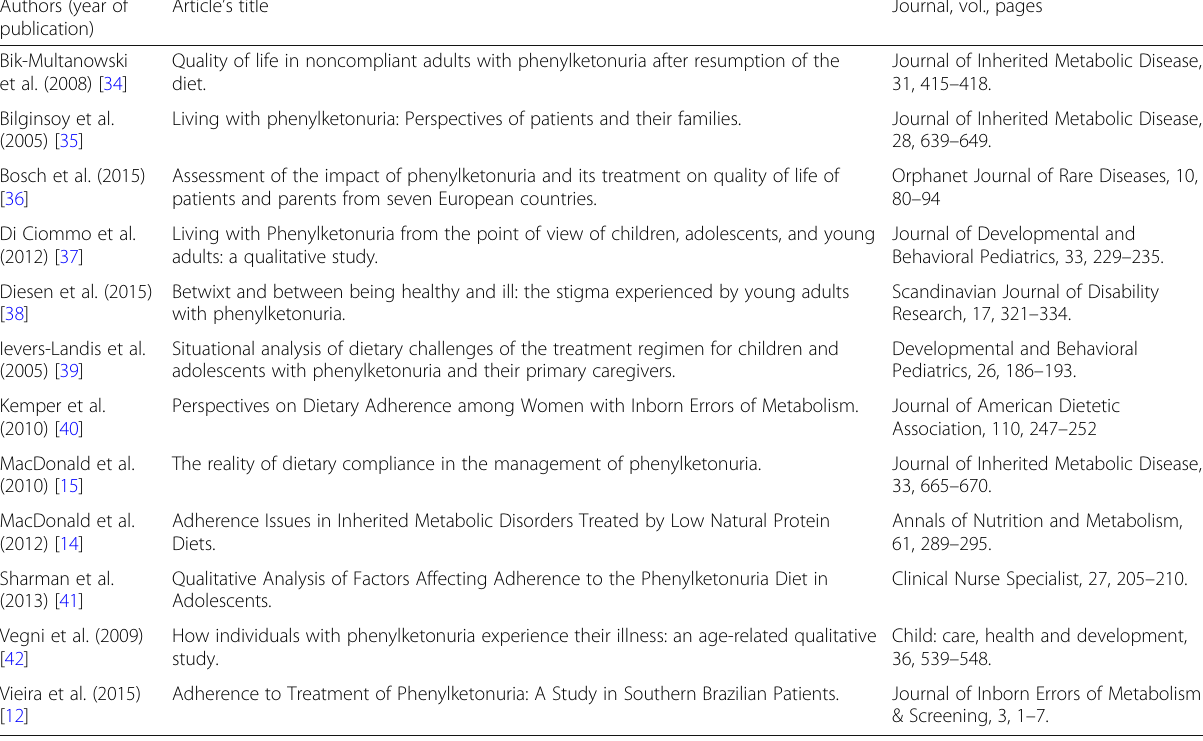
Table 1 Articles chosen from the literature to guide the questionnaire item construction Authors (year of publication)